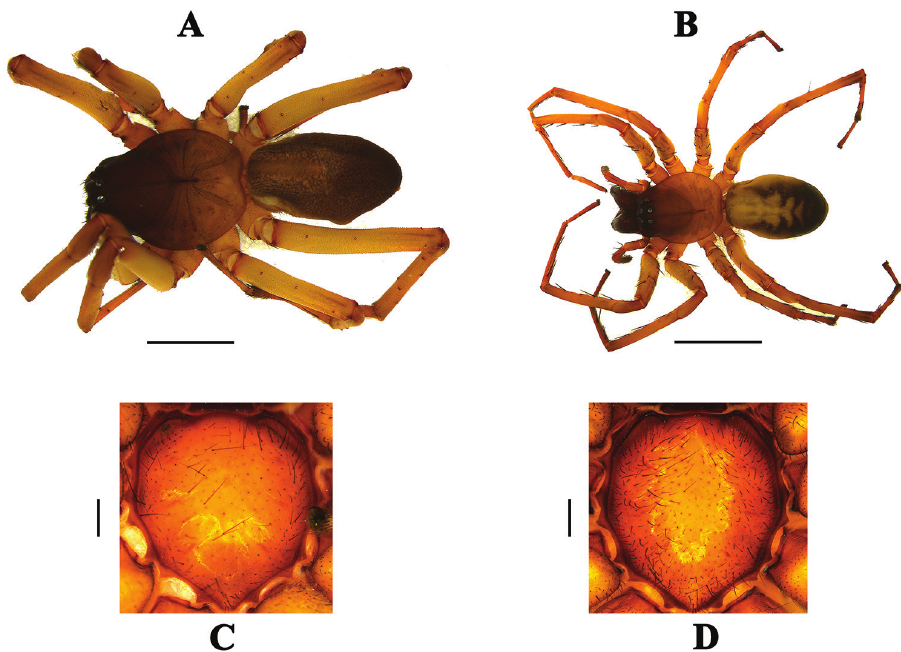
Figure 1. P. julioblancoi sp. n., holotype (ICN–Ar 8420), A habitus C sternum, paratype female (ICN-Ar 8421) B habitus D sternum. Scale bars 2 mm ( A ), 5 mm ( B ), 0.3 mm ( C ), 0.5 mm ( D